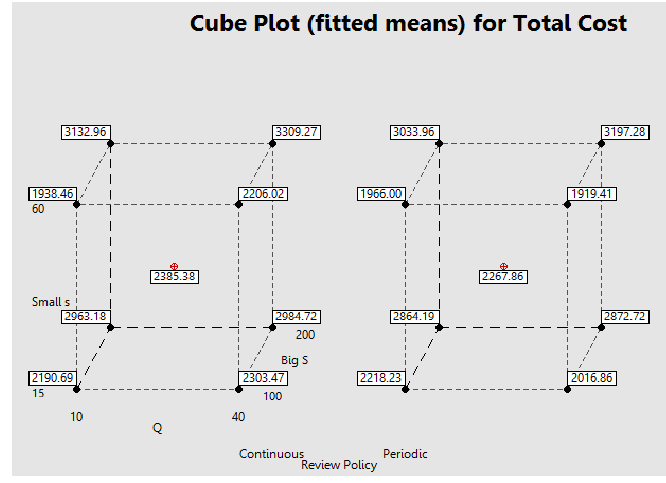
Figure 13. Cube plot of full factorial design.